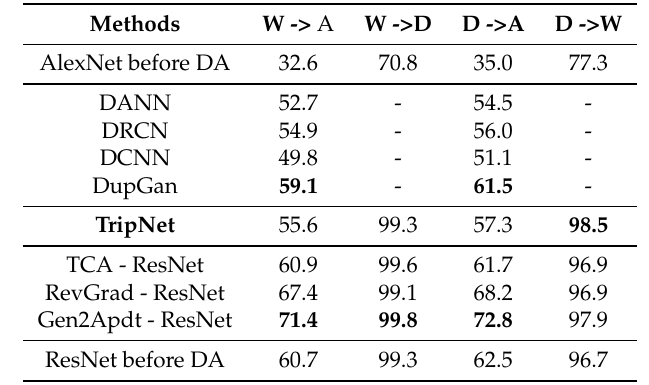
Table 2. Performance comparison on the OFFICE31 dataset, based on accuracy for unsupervised domain adaptation. Results were generated by averaging the results of five runs of our model, as well as using the reported results of the other papers. AlexNet-based experiments are separated with a bold line from ResNet based experiments; the best results are in bold for each; and the missing values are denoted by “-”.